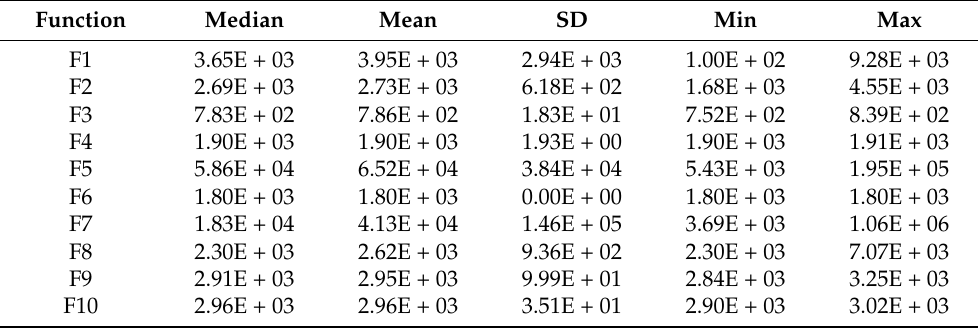
Table 4. The CEC 2020 ( D = 20) function values achieved by HBA over 50 runs and 50,000 func- tion evaluations.